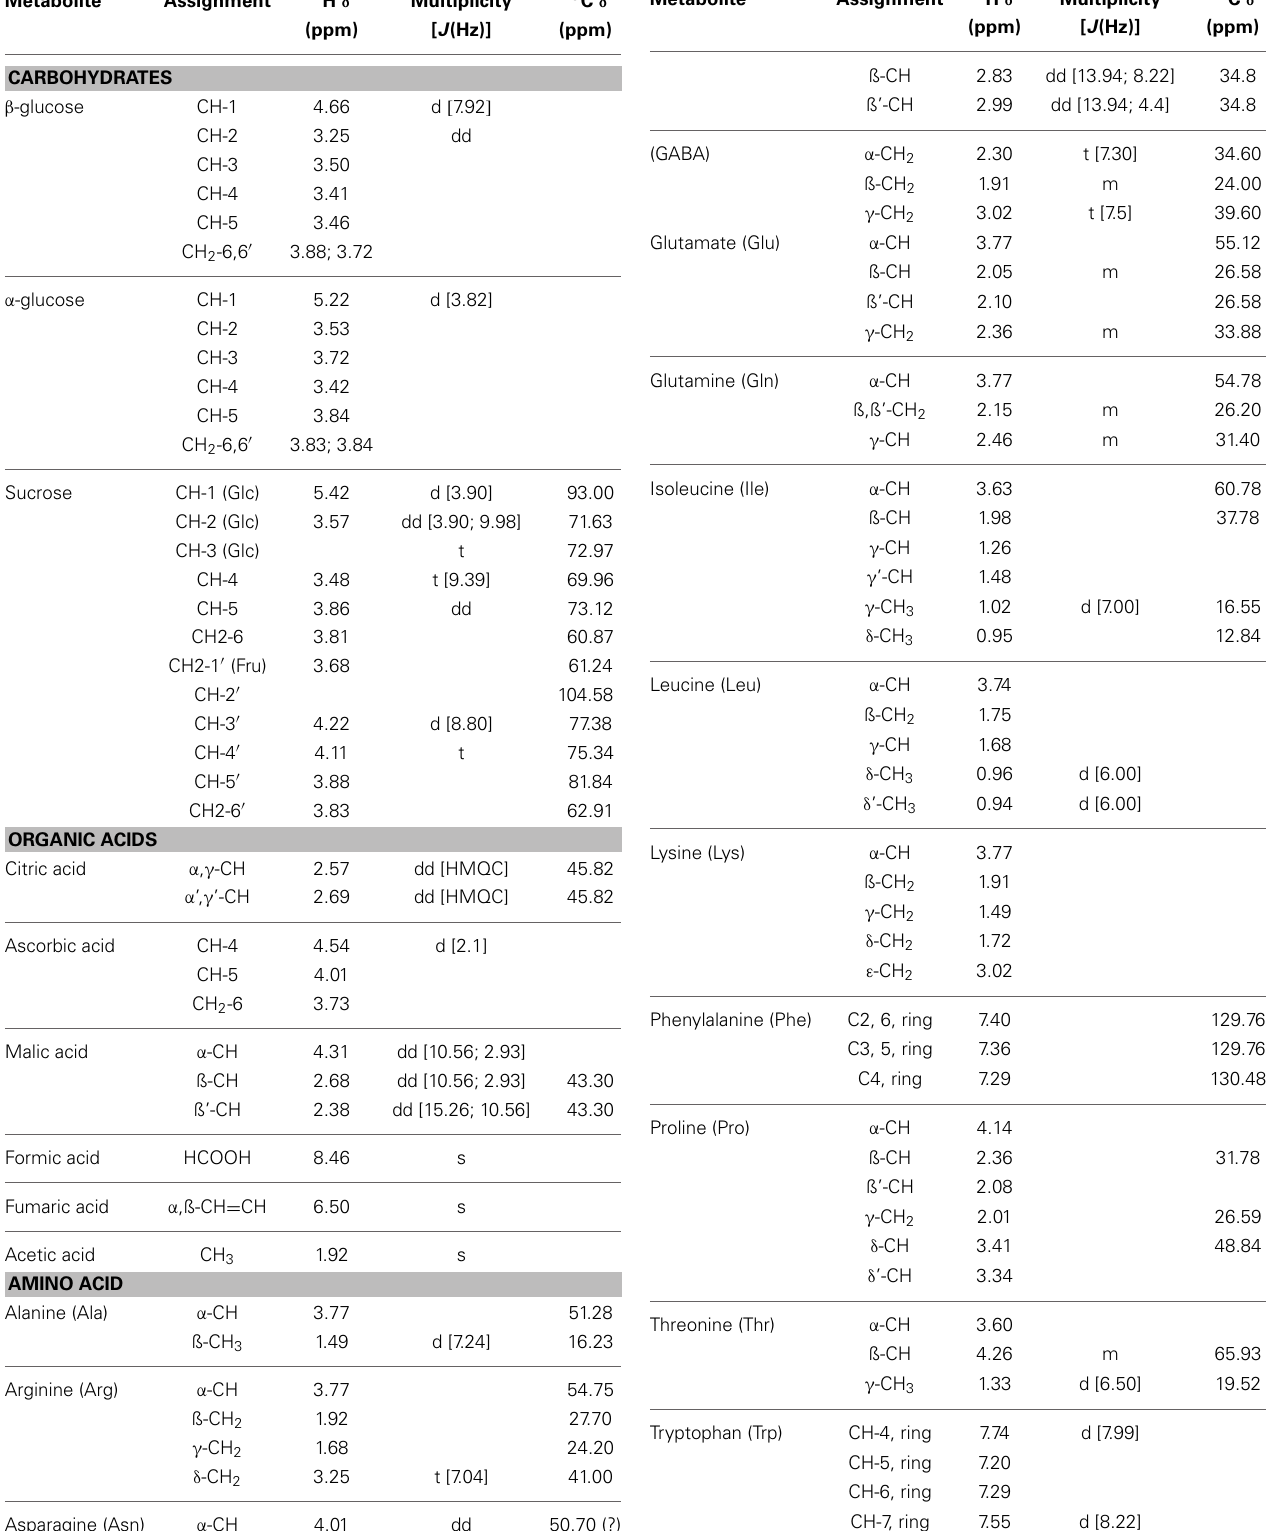
Table 3 | 1 H and 13 C chemical shifts of assigned